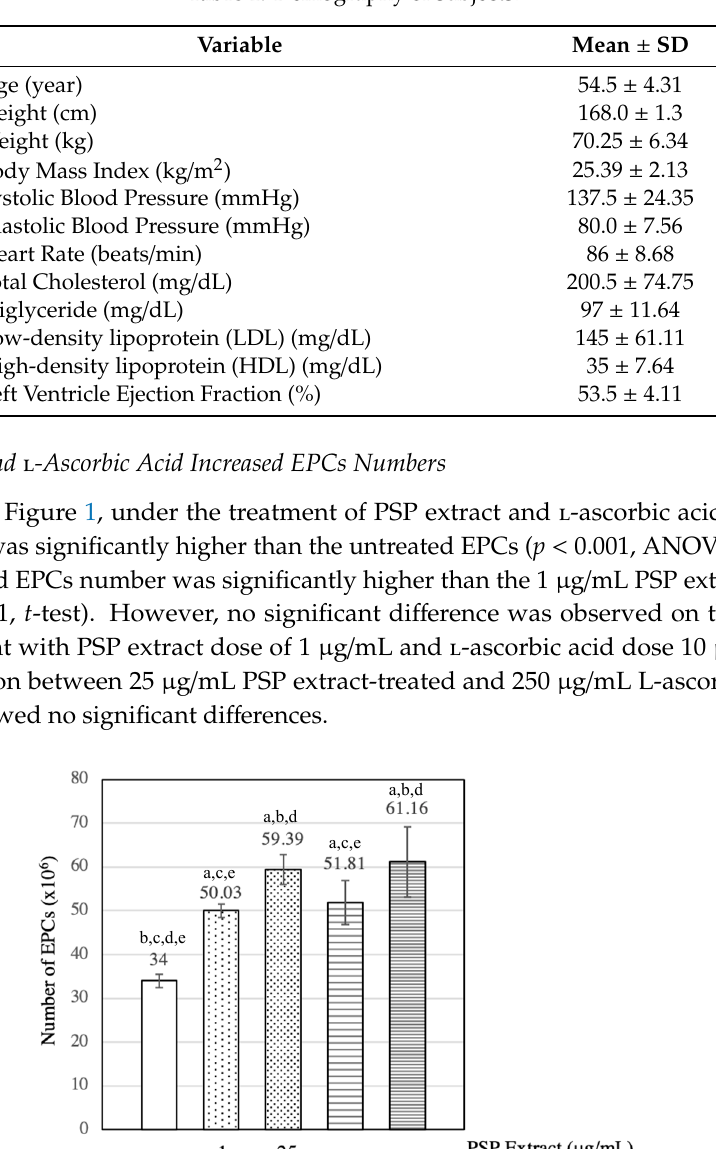
Table 1. Demography of